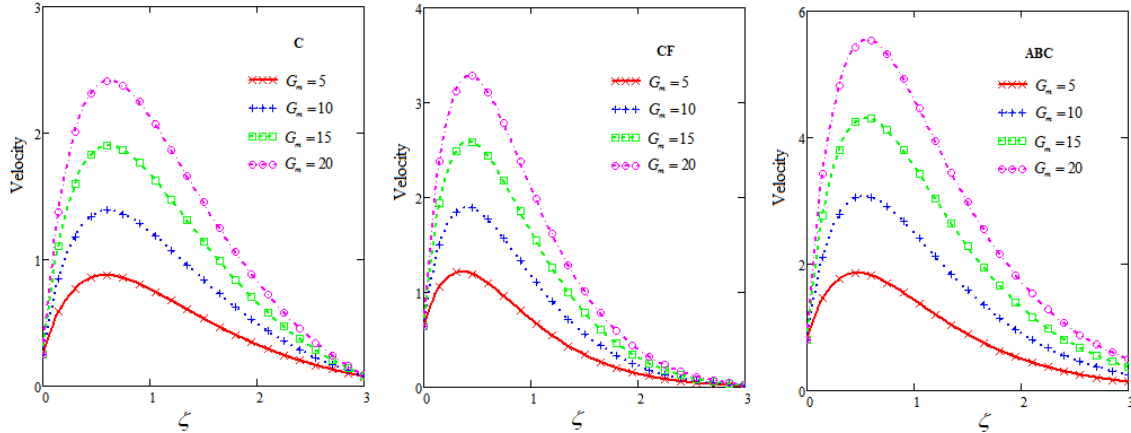
Figure 6. Velocity curves corresponding to C, CF and ABC with variable G m where P r = 7, S c = 0.66, κ = 0.5, G r = 10, H = 3, R = 5, S r = 3, K r = 2, M = 0.5, γ 1 = 0.1, h = 0.5, c = 1.05 and b = 0.75. The significant impact of K r on momentum and mass profiles is shown in Figure 7. Both the fluid flow and the concentration decay with the rise in the K r . The presence of chemical reaction reduces the buoyancy effects, which decreases and hence weakens the flow field. Clearly, the ABC model shows the highest velocity and concentration.